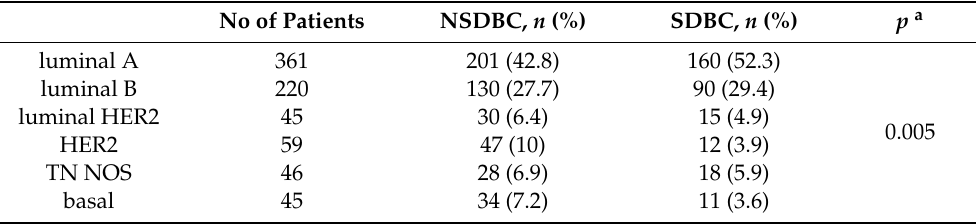
Table 4. Subrogate molecular classification of NSDBC and SDBC (PDP).